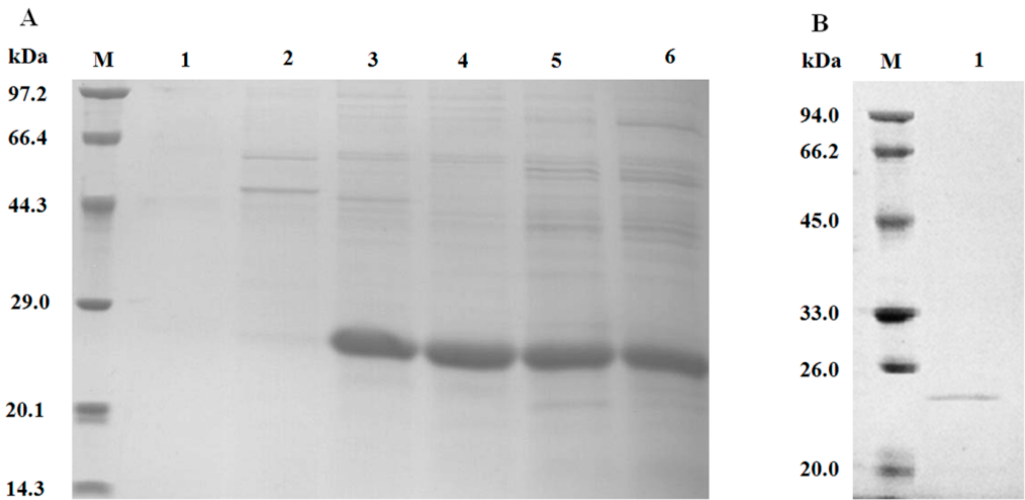
Figure 3. SDS-PAGE analysis. ( A ) Expressed proteins. Lane M: protein MW markers; Lane 1–6: the crude xylanase from P. pastoris pPICZ α A-optiXynB at 24 h, 48 h, 72 h, 96 h, 120 h, and 144 h. ( B ) Purified optiXynB. Lane M: protein MW markers; Lane 1: the purified optiXynB.